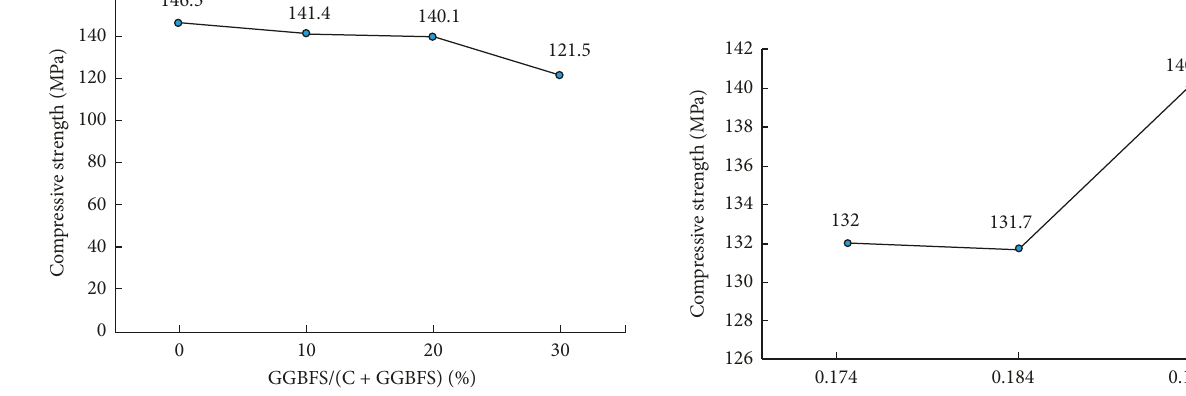
Figure 5: Influence of the content of GGBFS-replaced cement on the compressive strength of UHPFRC.